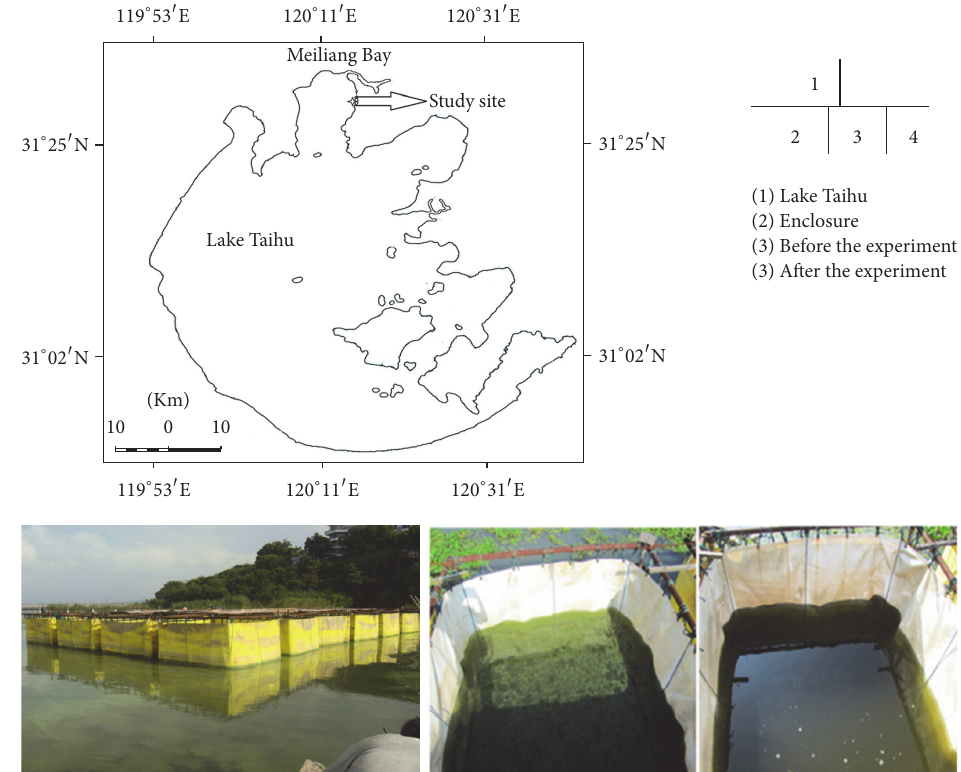
Figure 1: The study site and experimental